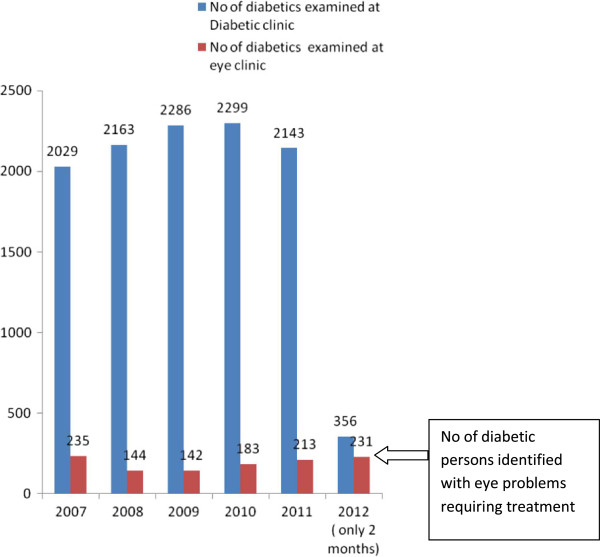
Comparative statistics of diabetic persons attending diabetes and eye clinic in the past 5 years with the study period.